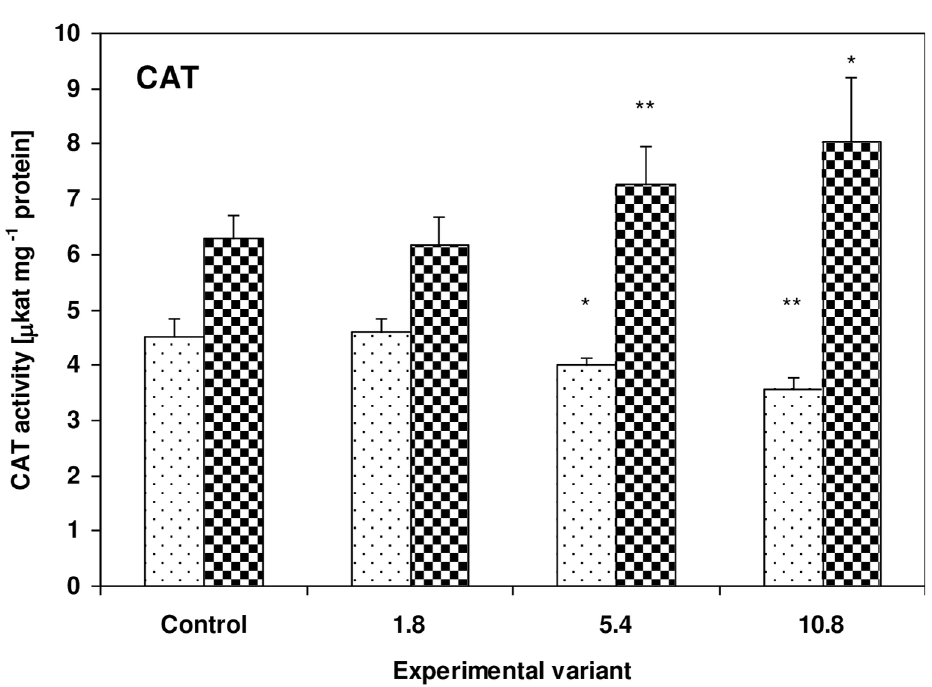
Fig 5. Activity of CAT in the leaves of zucchini (square without filling) and cucumber (square with dots) grown on the control and sewage sludge amended soil. Activities are expressed in μ kat mg -1 protein. For further explanation, see Fig